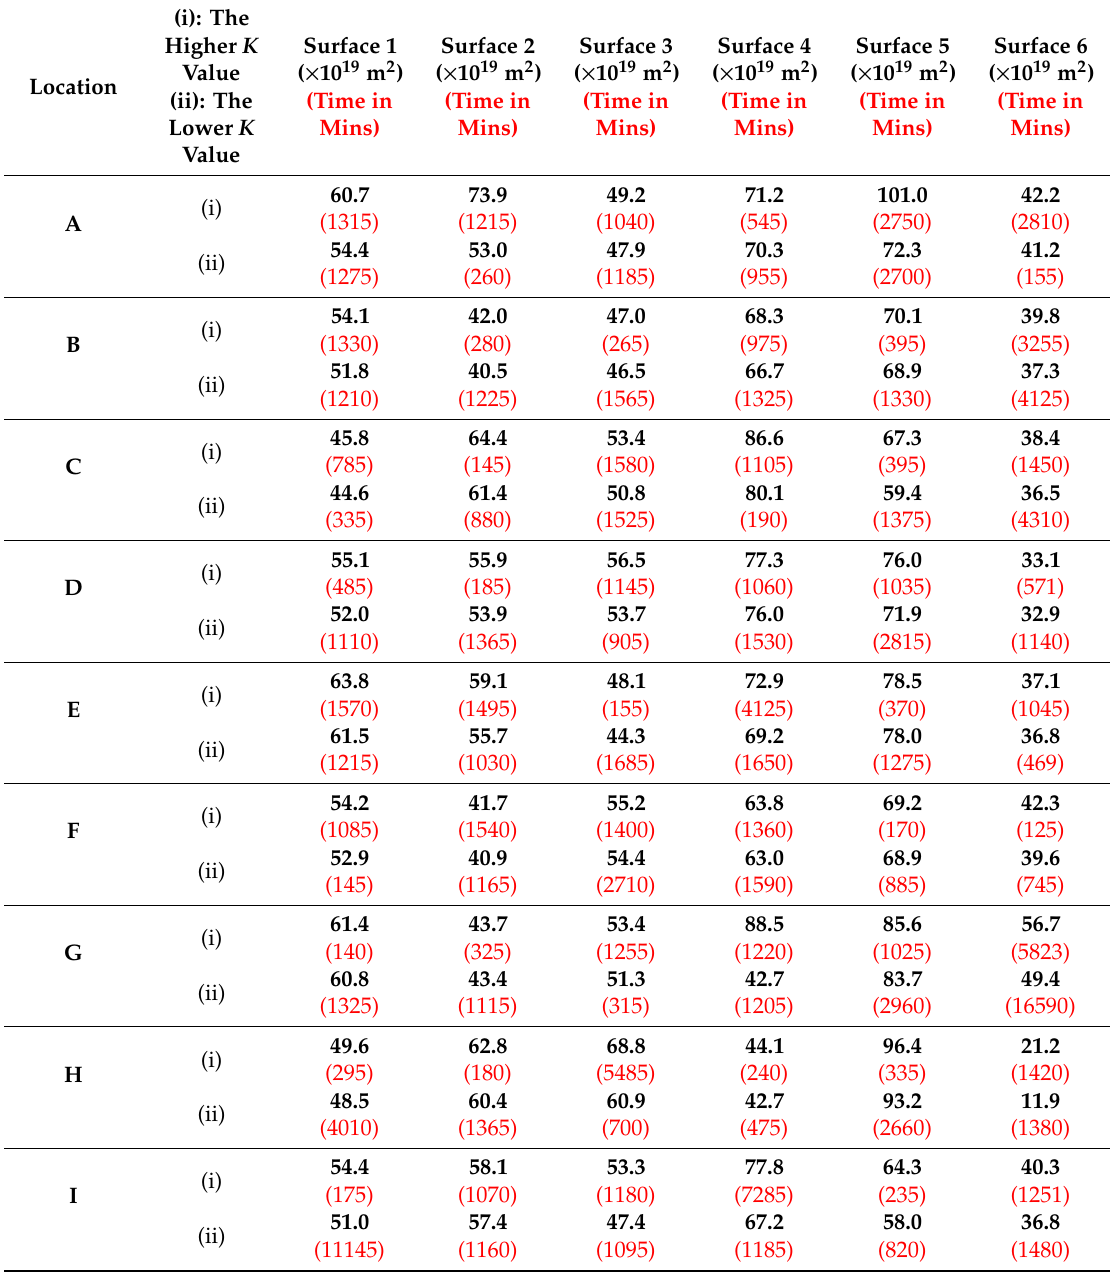
Table 3. Surface permeability data—Stanstead